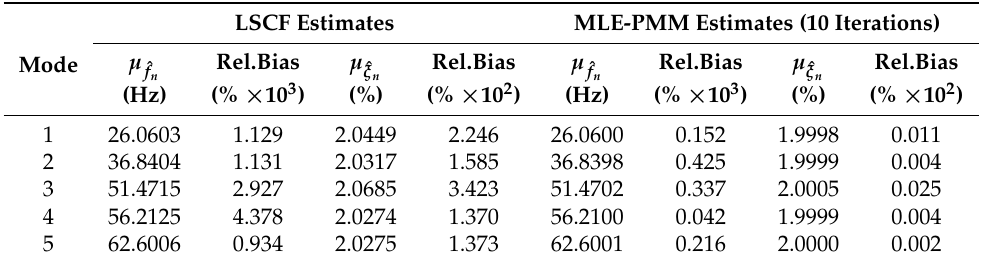
Table 4. Monte Carlo simulation results obtained from the simulated EMA of the five-DOF system: mean natural frequencies and damping rations and their respective relative bias error computed from the LSCF estimates and from the estimates obtained with the MLE-PMM technique after 10 iterations. LSCF Estimates MLE-PMM Estimates (10 Iterations) Mode